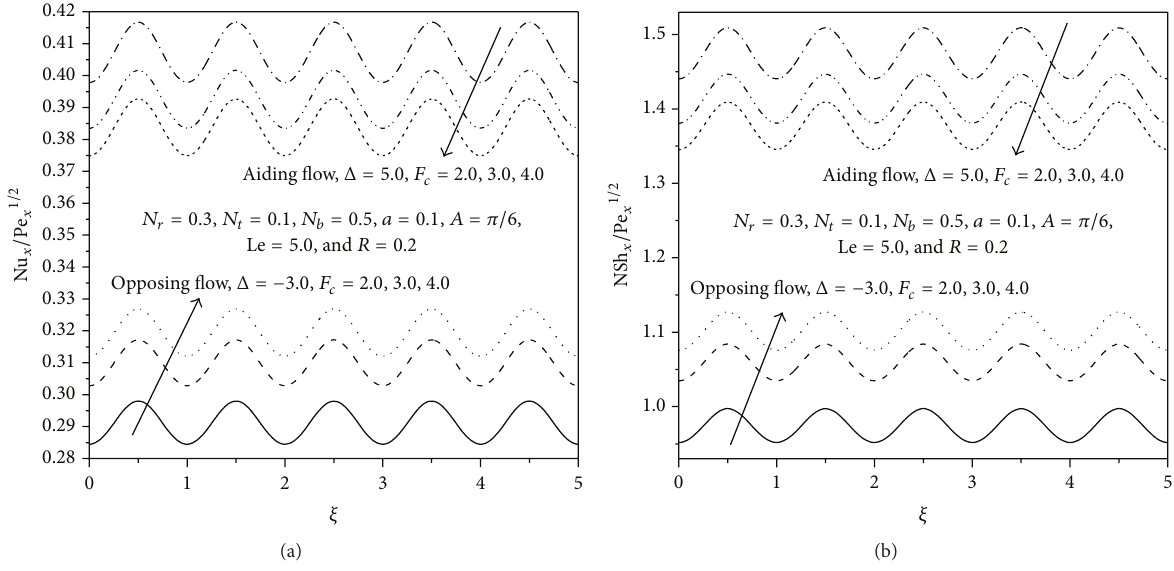
Figure 10: Effect of the non-Darcy parameter ( 𝐹 𝑐 ) on the heat and nanoparticle mass transfer rates.